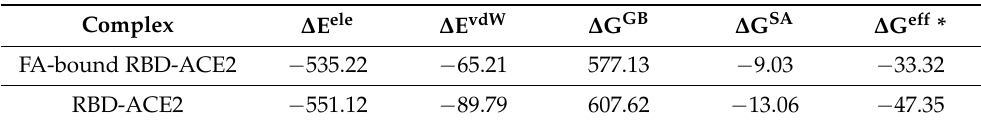
Table 1. The free energy results obtained from MM/GBSA calculations. Complex ∆ E ele ∆ E vdW ∆ G GB ∆ G SA ∆ G eff * FA-bound RBD-ACE2 − 535.22 − 65.21 577.13 − 9.03 − 33.32 RBD-ACE2 − 551.12 − 89.79 607.62 − 13.06 − 47.35